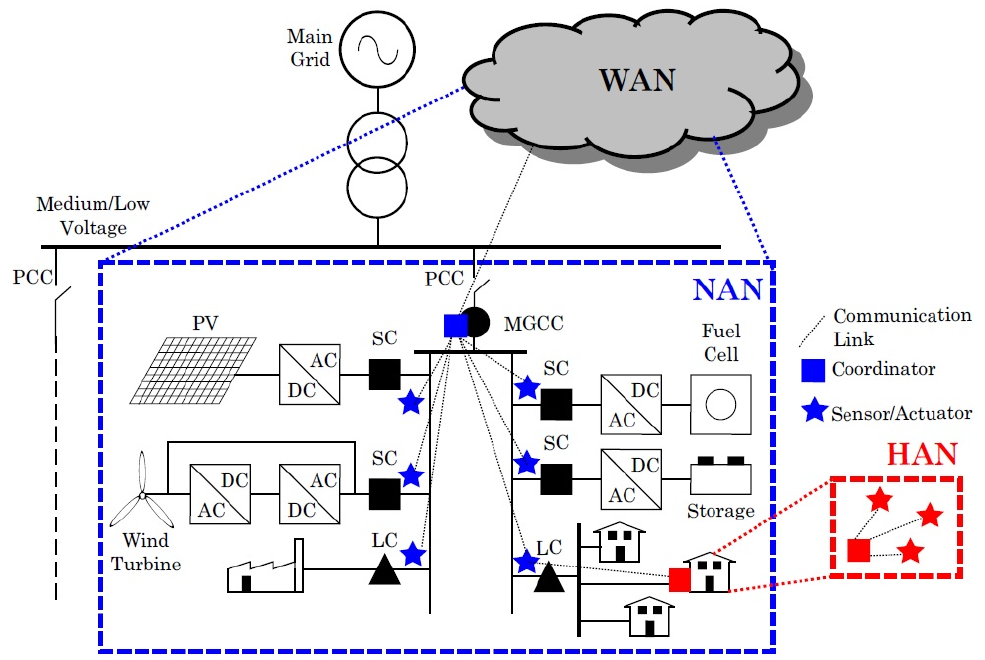
Figure 6. The three different communication network levels of a SG.